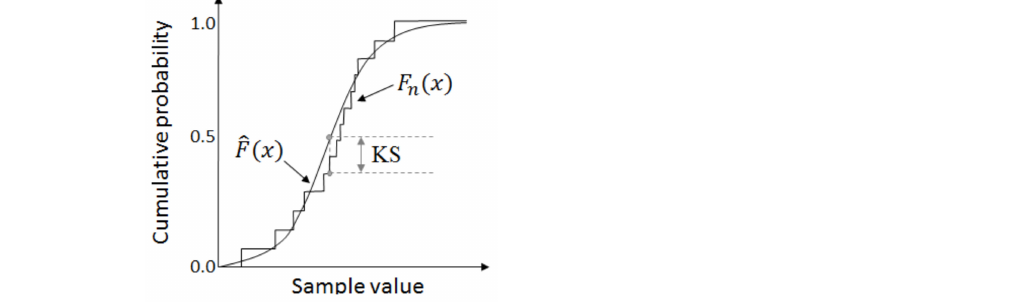
Figure 5. Kolmogorov–Smirnov statistic (KS) is the supremal distance between an empirical cumulative distribution and an MLE-parametrized cumulative distribution. A small KS indicates a good